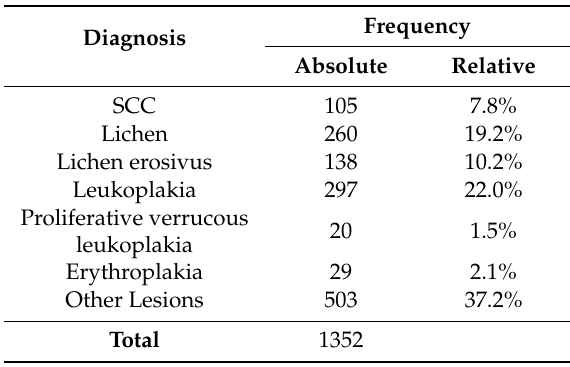
Table 2. List of diagnoses and their frequencies.